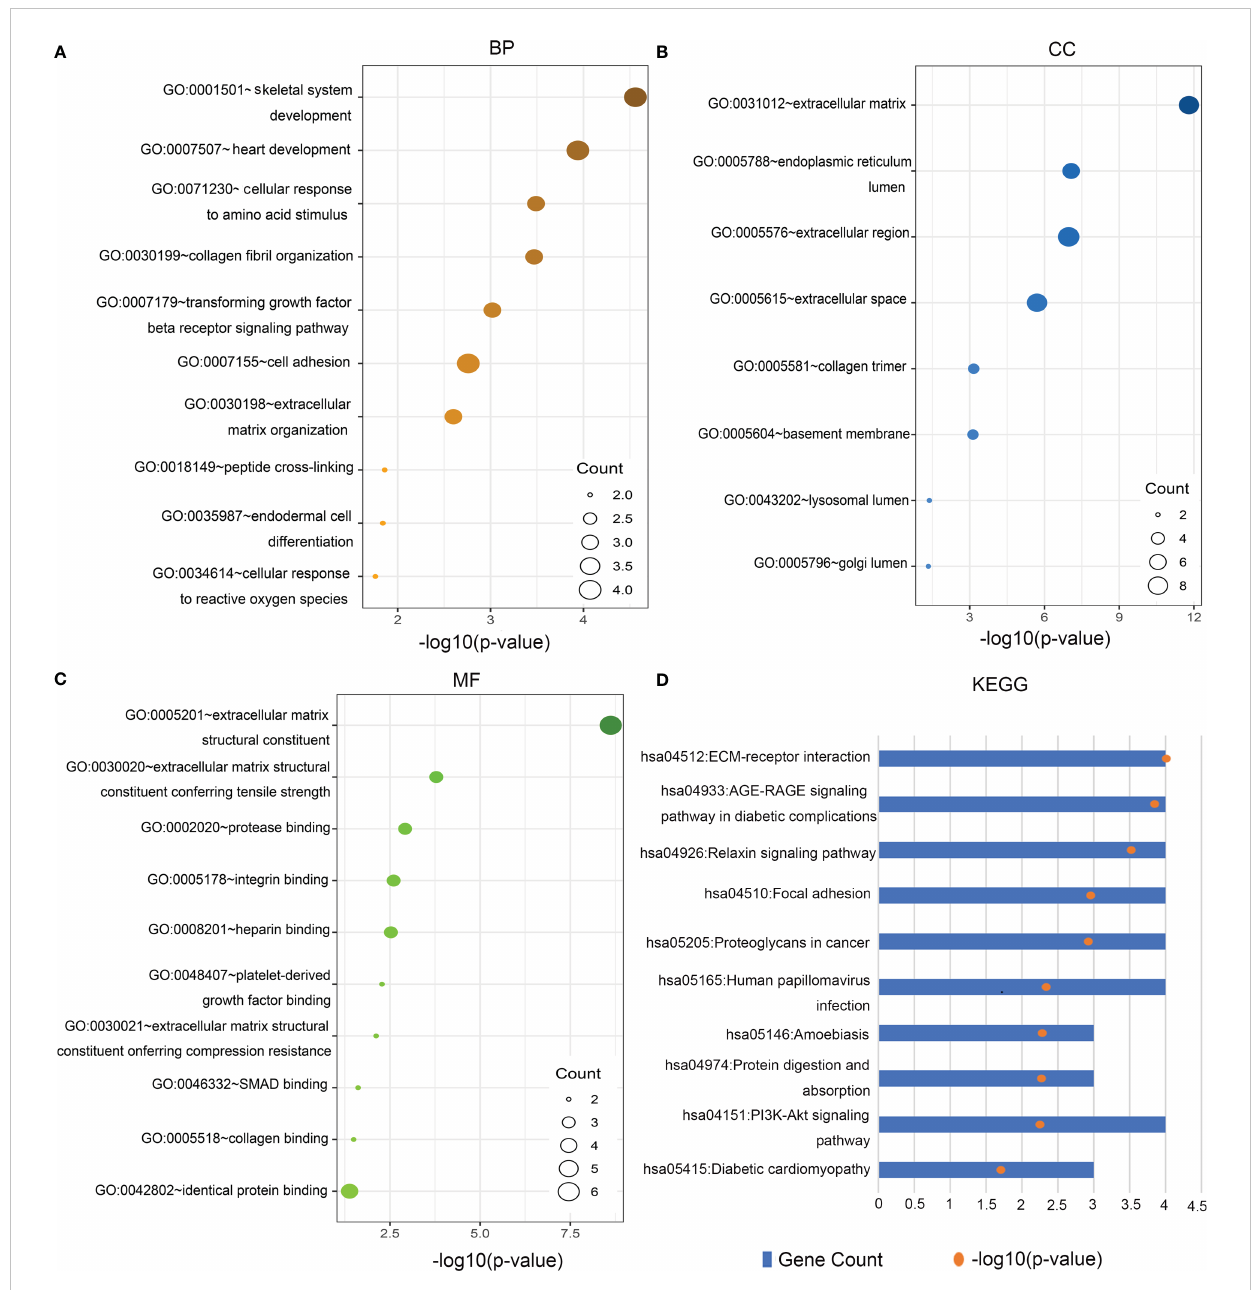
FIGURE 3 Gene Ontology (GO) function and Kyoto Encyclopedia of Genes and Genomes (KEGG) pathway analysis of Hub genes. (A) Biological Processes (BP), (B) cellular components (CC), (C) molecular functions (MF), (D)